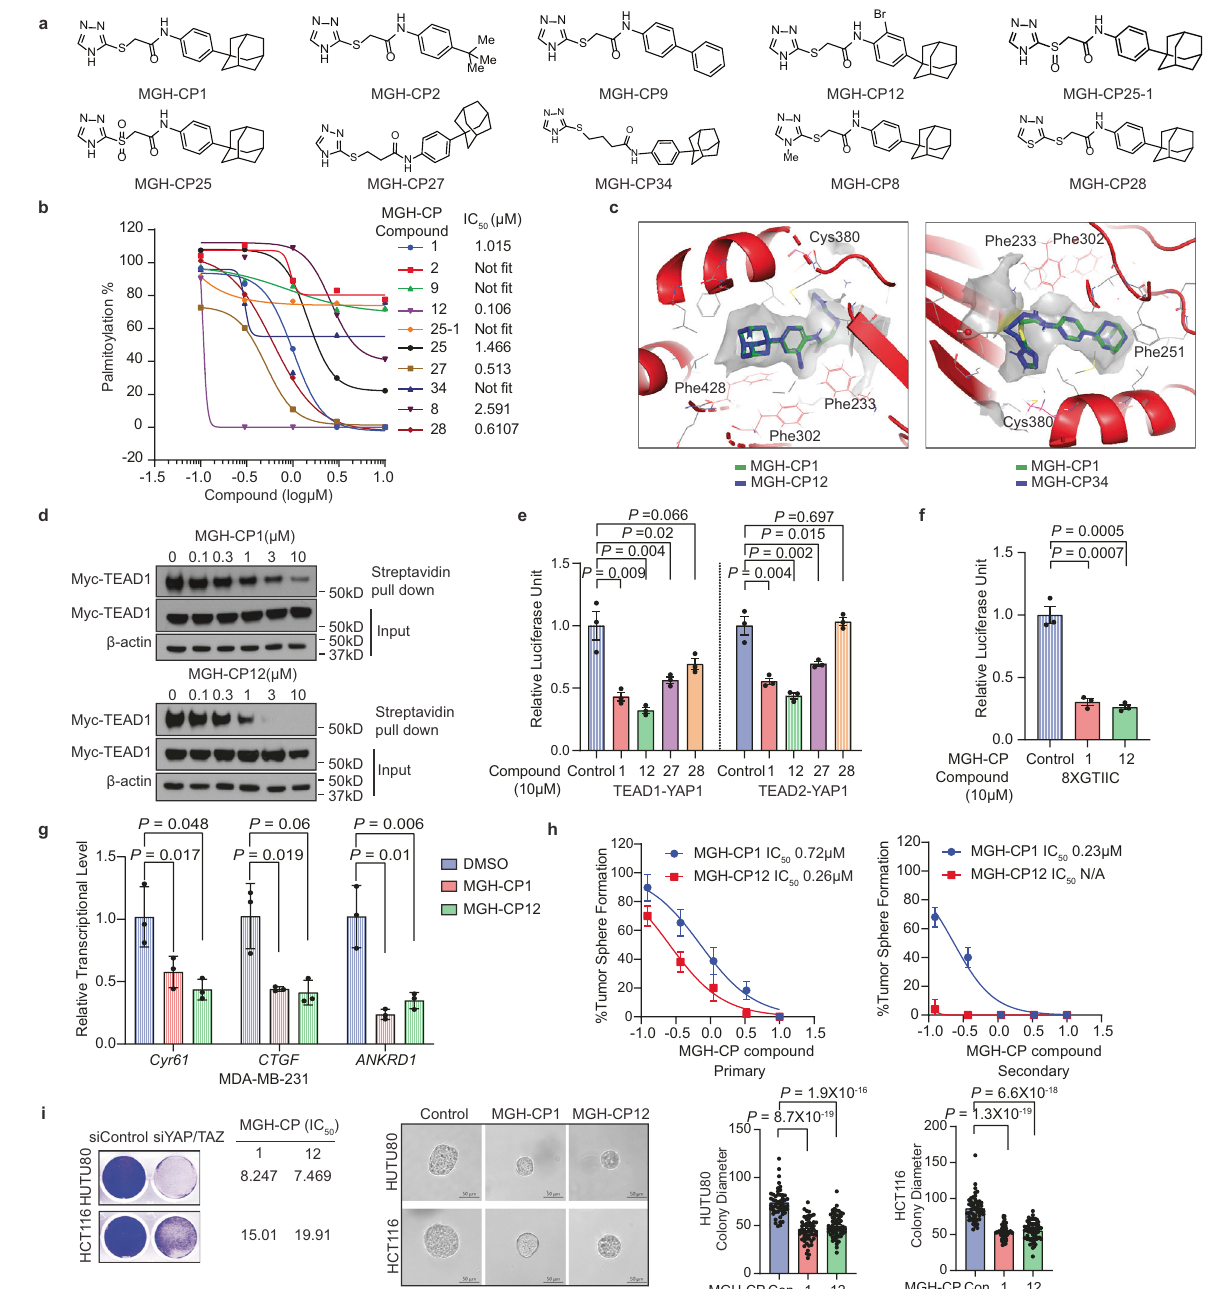
Fig. 1 | MGH-CP1 and analogues are palmitoylation inhibitors with different outcomes in blocking TEAD – YAP activities. a Structures of MGH-CP1 and its analogues. b Inhibition of TEAD2 YAP-binding domain (YBD) in vitro autopalmi- toylation by MGH-CP compounds. c The MGH-CP12 and MGH-CP34 were